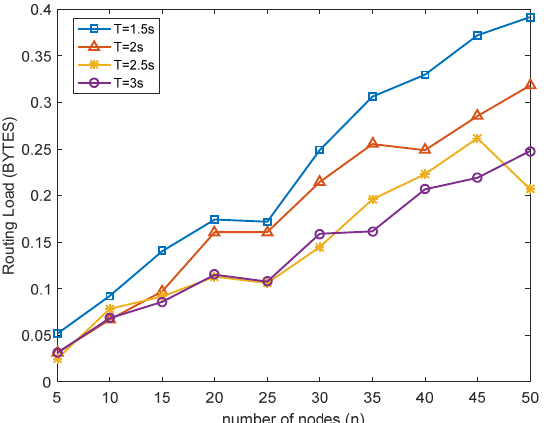
Figure 10. Comparison of pulse cycle routing load of beacon routing protocol.